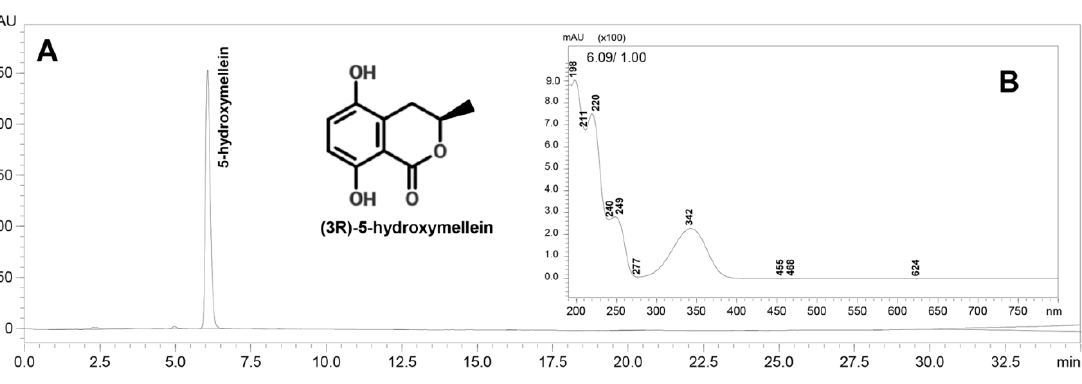
Figure 3. ( A ) HPLC chromatogram of the purified single compound acquired at 254 nm. The molecular structure of (3 R )-5-hydroxymellein is presented in the insets; ( B ) UV spectra of the purified single compound (0.2 mg/mL).